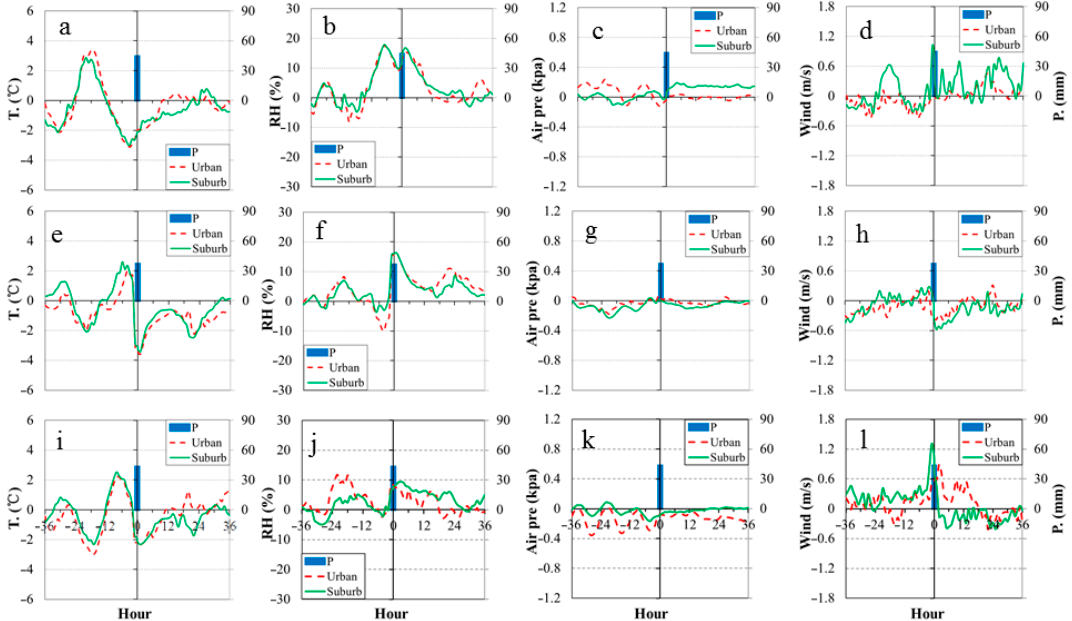
Figure 8. Anomalies of air temperature, relative humidity, surface pressure, and wind speed during 36 hours prior to and post the monsoon storms that occurred in the morning (8:00–12:00; a – d